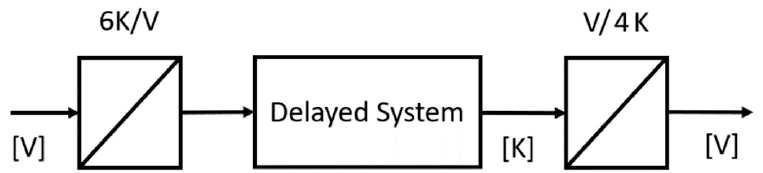
Figure 8. Block diagram of the temperature chamber including actuator and sensor.